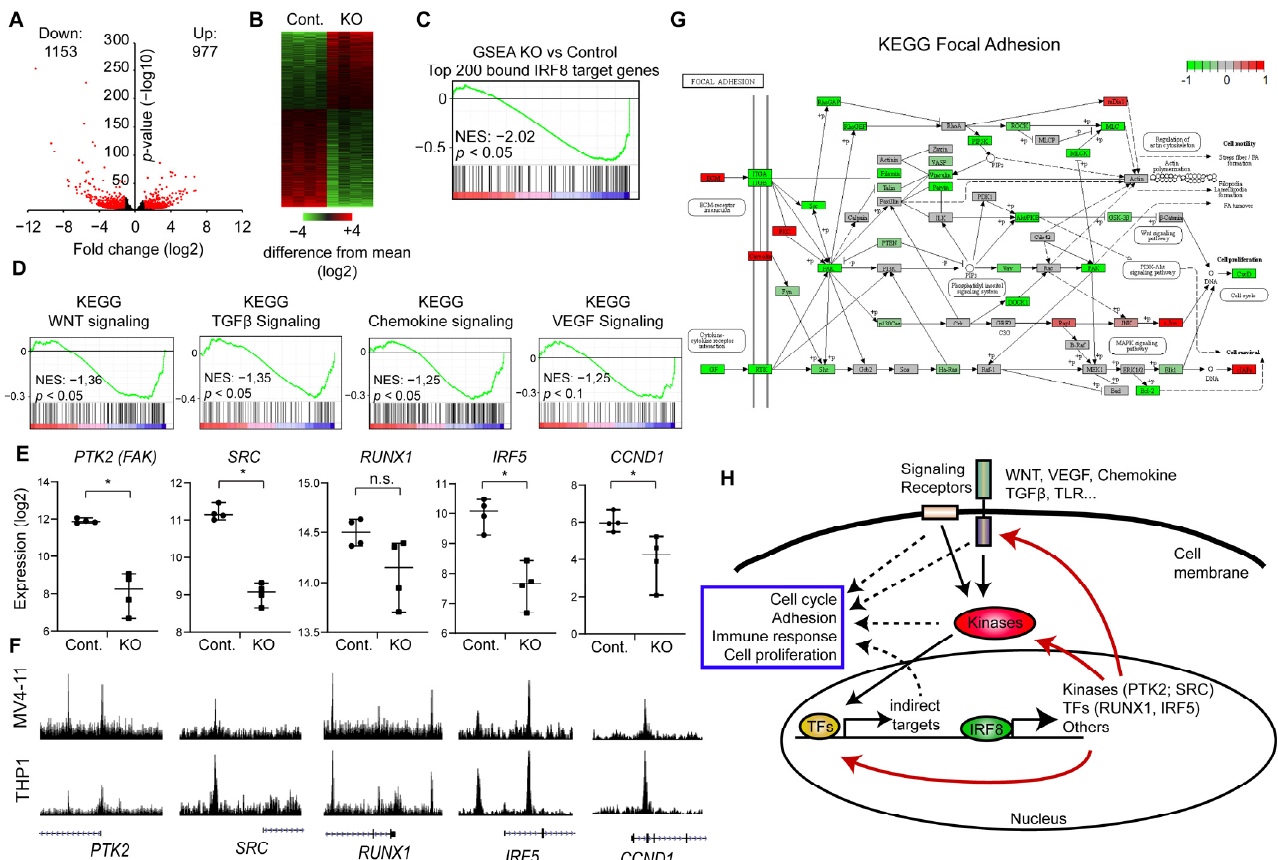
Figure 5. IRF8 deletion downregulates key signaling and focal adhesion pathways. ( A ) Volcano-plot showing up- and downregulated genes upon IRF8 deletion. ( B ) Heatmap depicting the up and down regulated genes. ( C ) Gene set enrichment analysis (GSEA) of the top 200 genes with the highest IRF8 promoter levels, demonstrating that those genes become predominantly downregulated upon IRF8 deletion. NES = Normalized Enrichment Score ( D ) GSEA of several important signaling pathways, that become downregulated upon IRF8 deletion. NES = Normalized Enrichment Score. ( E ) Gene expression changes of key regulators upon IRF8 deletion, based on RNA-Seq data. * p < 0.05, n.s. not significant. (Student’s t-test). ( F ) Enrichment of IRF8 at the genes from ( E ) in MV4-11 (this study) and THP1 cells [29] . ( G ) Kyoto Encyclopedia of Genes and Genomes (KEGG)-pathway analysis of focal adhesion. Green are components that are downregulated upon IRF8 deletion, while red boxes indicate upregulated factors. ( H ) Model of the function of IRF8 in AML cells.